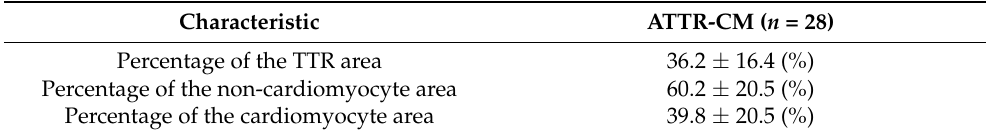
Table 2. Measurements of pathological features of the patients with ATTR-CM.